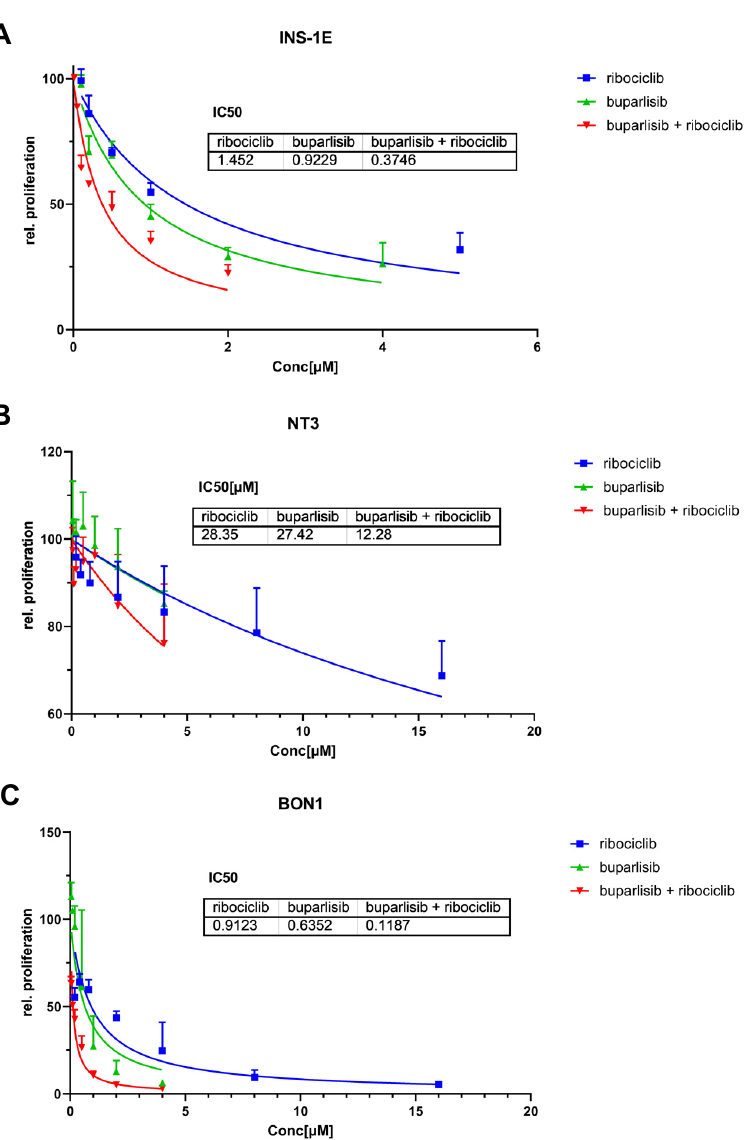
Figure 1. Effect of buparlisib and ribociclib on cell proliferation of INS-1E, NT-3 and BON-1 PanNET cells in 2D culture. INS-1E ( A ), NT-3 ( B ) and BON-1 ( C ) cells were treated with buparlisib, ribociclib, a combination of both drugs or DMSO vehicle control. Cell proliferation was measured after 72 h of treatment. The DMSO control was set to 100% and nonlinear regression was used to determine the IC50. Data shows the mean ± SD from three independent experiments with three technical replicates each.